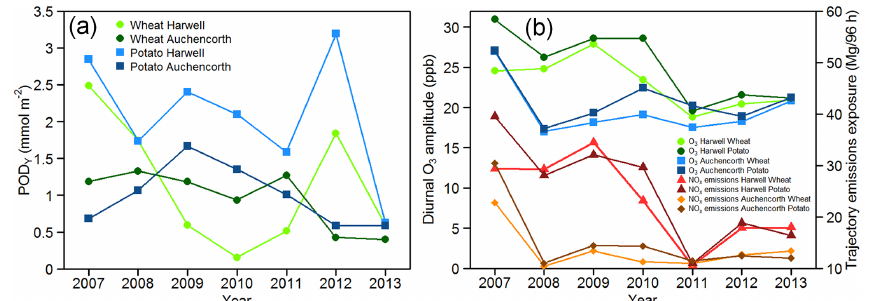
Figure 11. Comparison of O 3 vegetation impact chemical climates for wheat and potato 2007–2013: (a) annual POD Y for wheat and potato, (b) diurnal O 3 amplitude during June accumulation days (ADs) at Harwell and Auchencorth and trajectory NO x emission estimates at Harwell and Auchencorth.